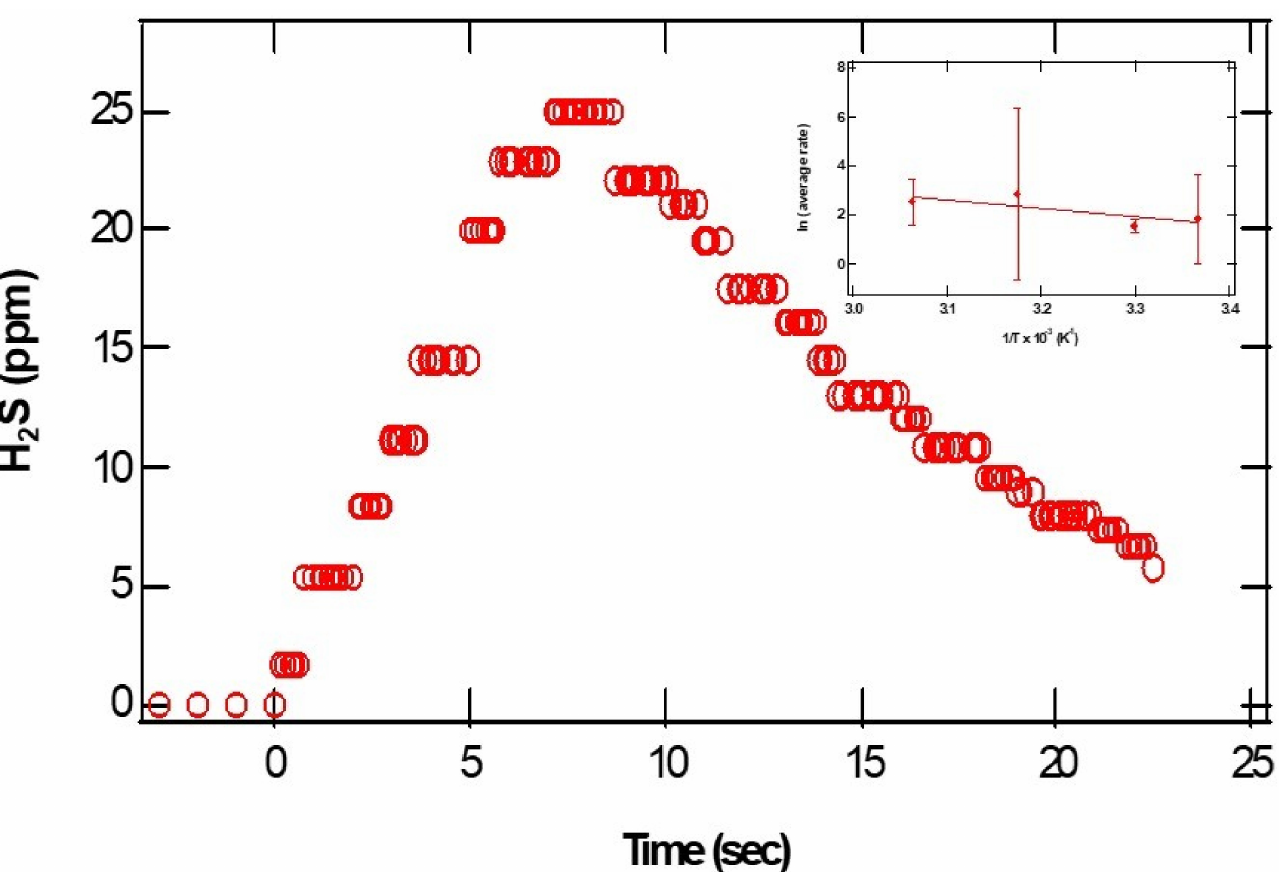
Figure 3. The open circles represent the parts per million of H 2 S detected as a function of time. The pH of the acidic solution employed was 0.70. The initial amount of CaS(s) is 0.01 mg. The closed circles in the insert on the upper right-hand side represent the In(r) as a function of